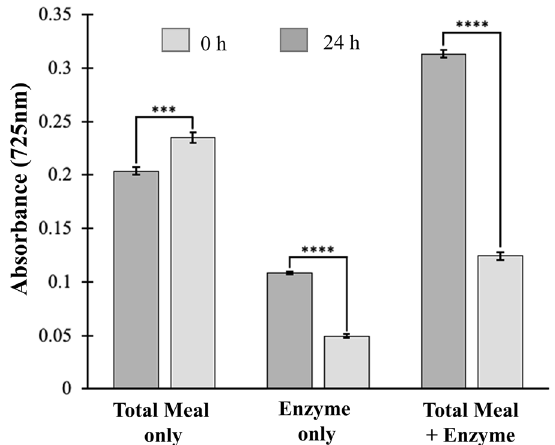
Fig. 5 Effect of extended BLC23O reaction time on phenol content of faba bean meals. Change in total meal phenol content after 24 h reaction with BLC23O. 1.2 mg/mL of meal flour and 0.06 mg/mL of BLC23O were left to react at room temperature for 24 h and then reacted with the Folin–Ciocalteu reagent. Data are presented as the mean and standard deviation of the % absorbance at 725 nm (n